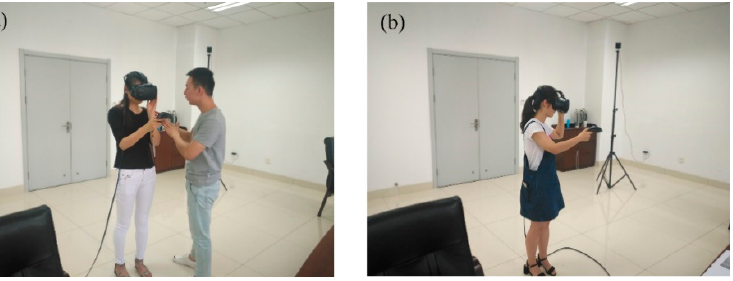
Figure 4. Experimental process. ( a ) The staff explained the experimental requirements and precau- tions to the participants. ( b ) The participants independently completed the